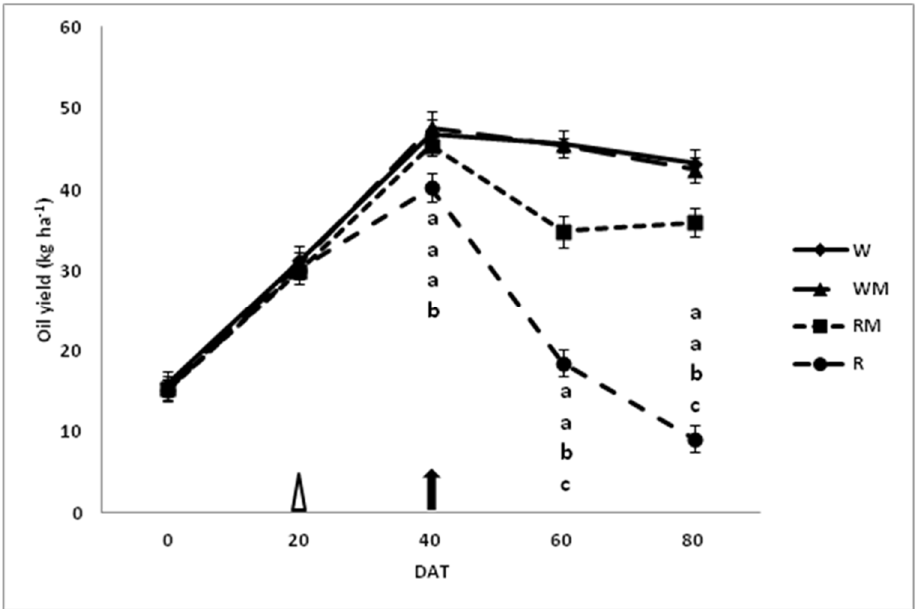
Figure 8. Changes in essential-oil yield (kg ha -1 ) of spearmint exposed to the following treatments: R—rainfed without straw mulch, RM—rainfed with straw mulch, W—well-watered control plants and WM—well-watered with straw mulch. Measurements were performed 0, 20, 40, 60 and 80 days after the onset of the treatments (DAT). Vertical bars represent ± SE of the mean ( n = 3). Bars with different letters indicate significant differences among treatments in the given DAT at p ≤ 0.05. Triangle at 20 DAT indicates the early bloom, and arrow at 40 DAT indicates the full bloom, in overall treatments.